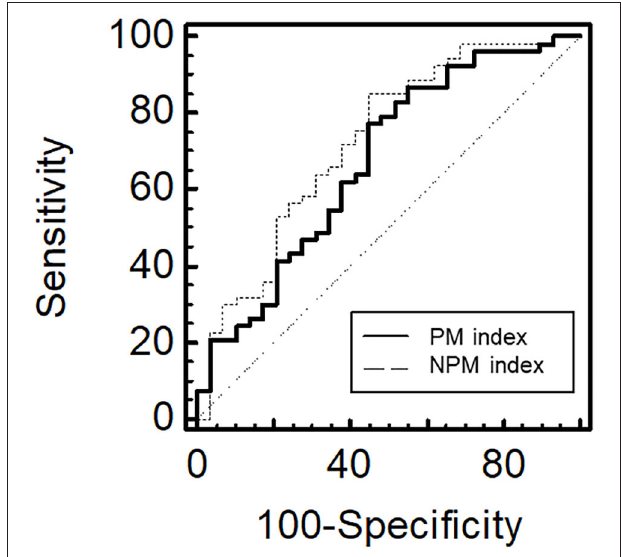
FIGURE 1 | The area under the receiver operating characteristic curve for the PM or NPM indices for predicting low gait speed. NPM, normal density-psoas muscle; PM, psoas